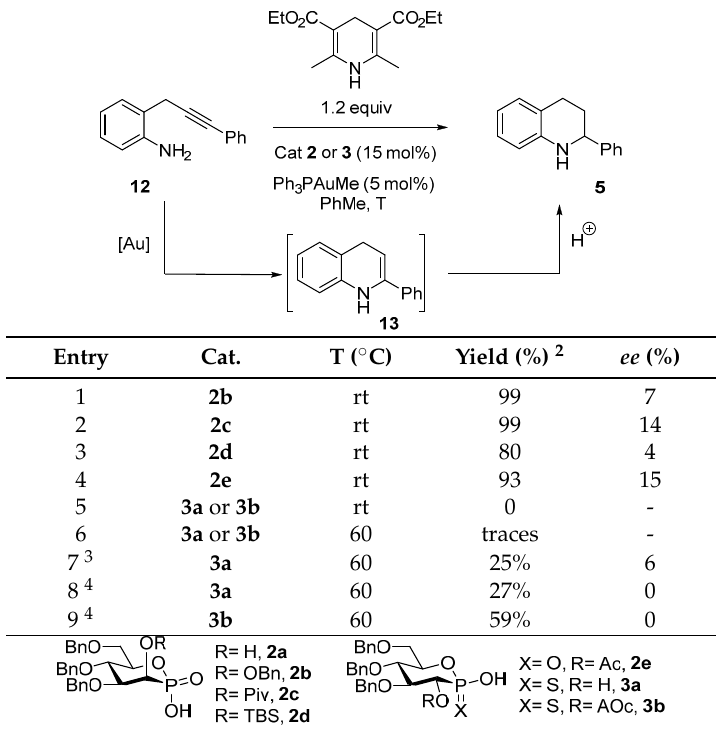
Table 3. Catalytic activity of phosphonate-Au(I) complexes 1